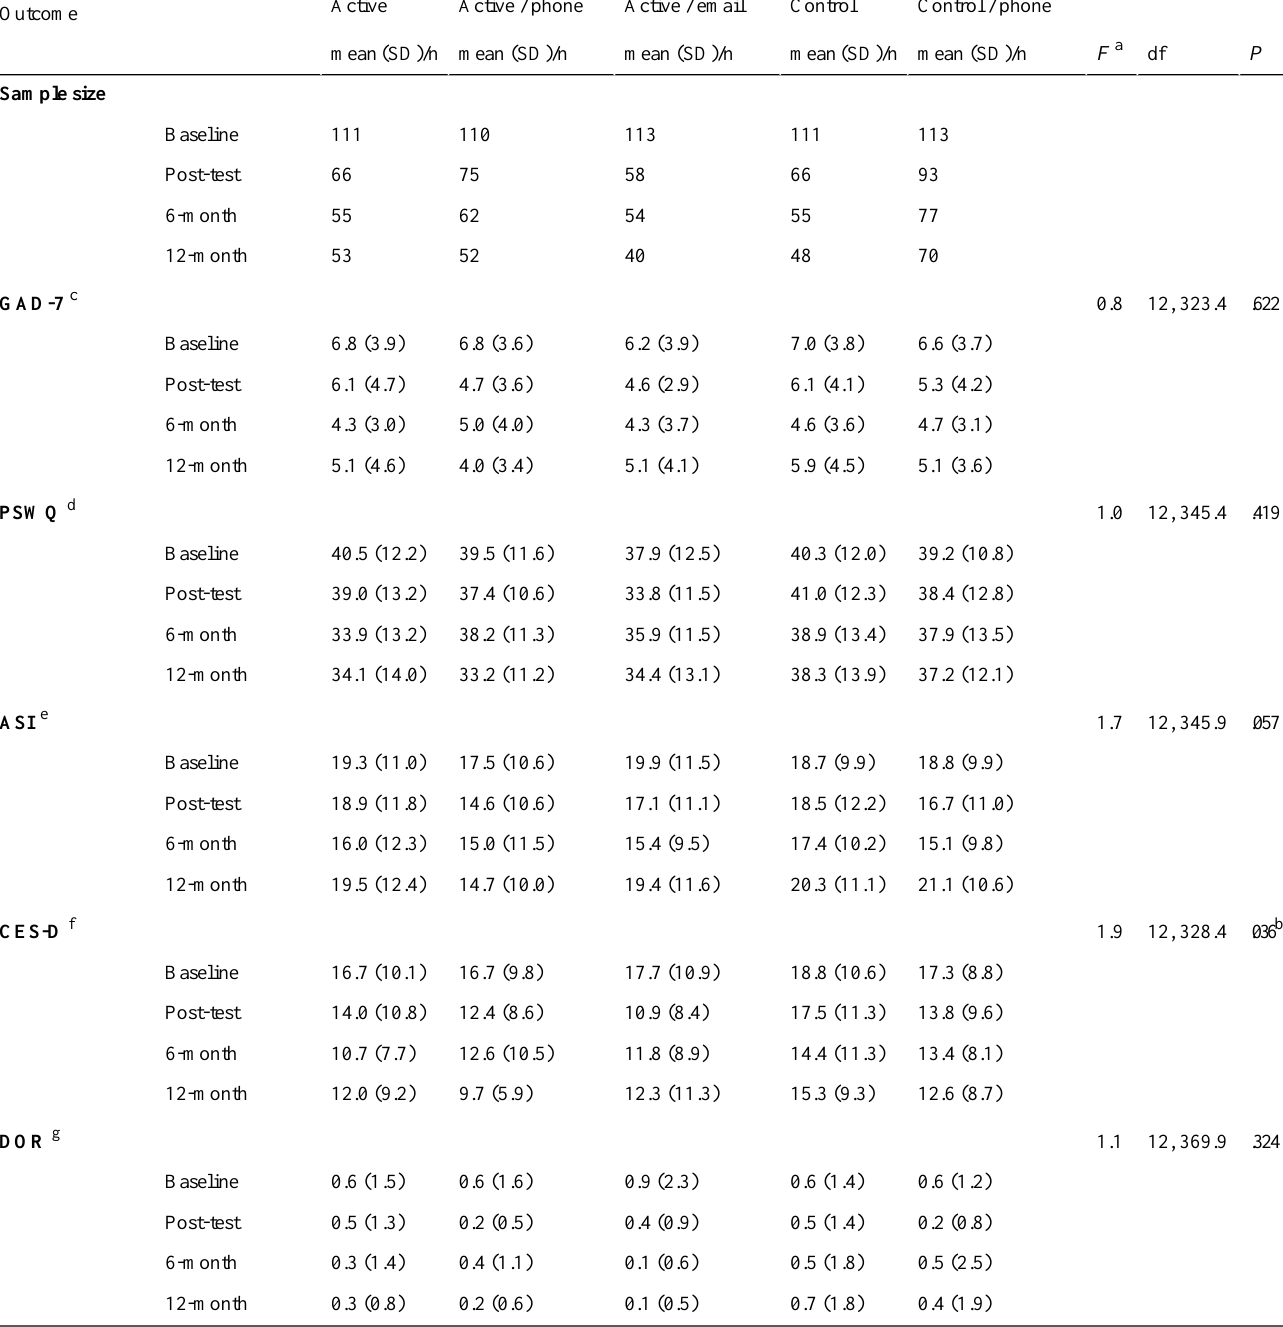
Table 3. Primary and secondary outcome data.